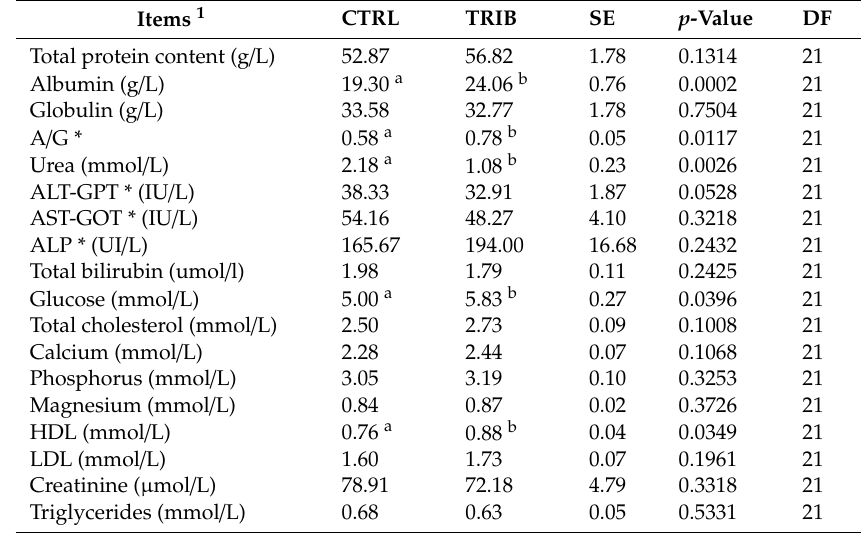
Table 3. Serum concentrations of the di ff erent parameters analysed in piglets fed on a diet supplemented with (TRIB; n = 60) or without (CTRL; n = 60) 0.2%